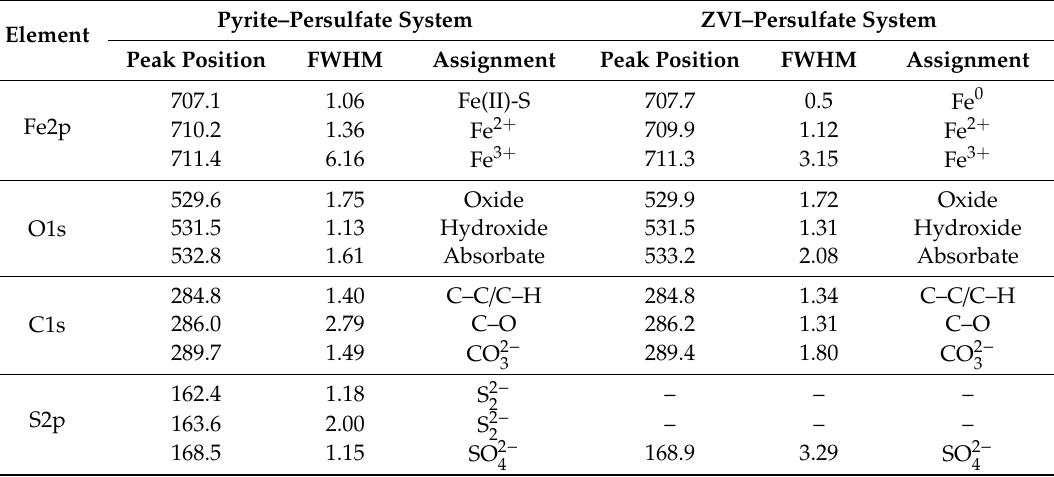
Table 1. Summary of X-ray photoelectron spectroscopy (XPS) spectrum